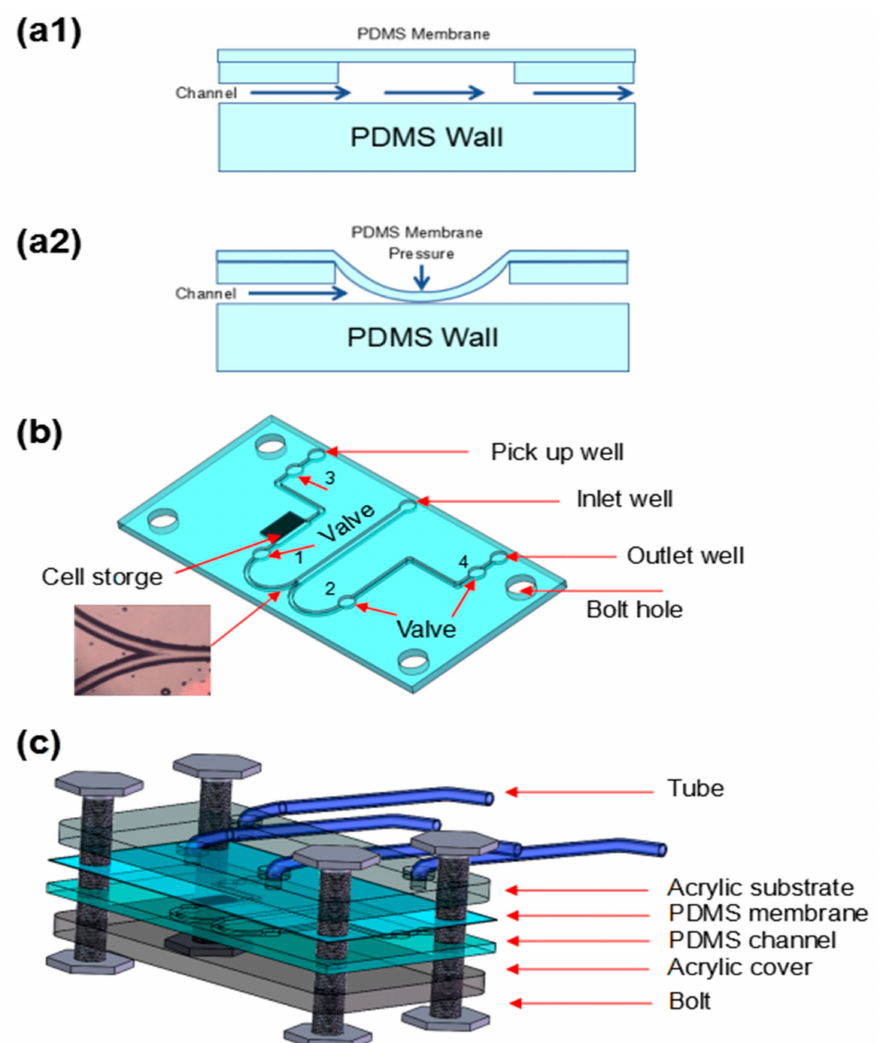
Figure 1. The principle, design and layer structure of the device. ( a1 ) Polydimethylsiloxane (PDMS) membrane-actuated valve structure. ( a2 ) PDMS membrane-actuated valve structure with applied pressure. The channel was closed by the deflected membrane. ( b ) The channel layer of the cell capturing device. The branch is the image recognition area for capturing Euglena . ( c ) Layered illustration of the device of PDMS membrane-actuated